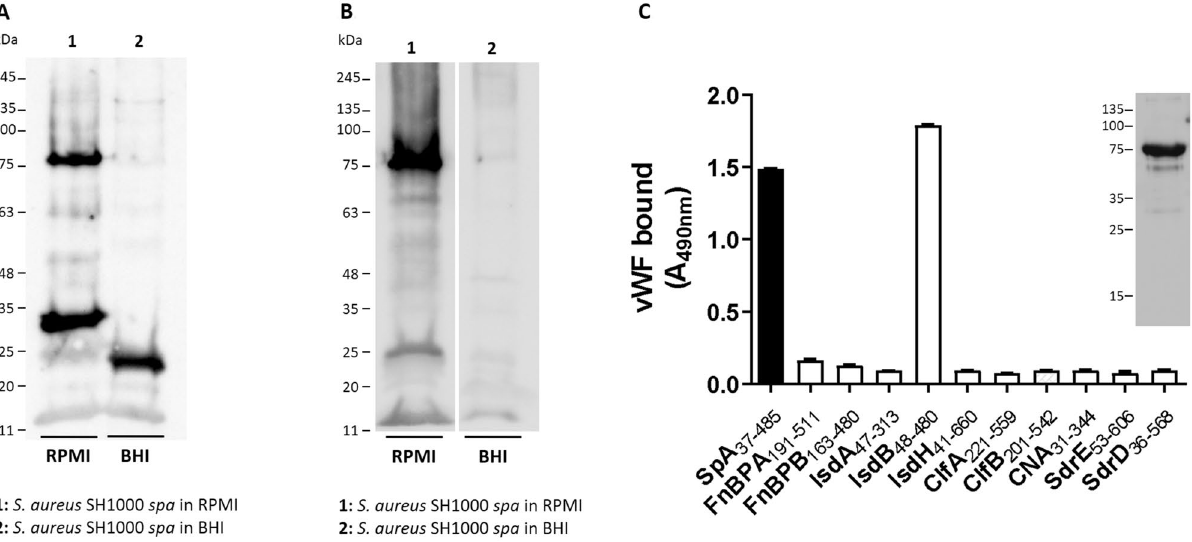
Figure 1. Identification of a vWF receptor in S. aureus SH1000 spa . (A) Lysostaphin-released material from S. aureus SH1000 spa grown in RPMI (lane 1) and BHI (lane 2) was subjected to Far Western Blotting. The nitrocellulose membrane was probed with human vWF followed by polyclonal rabbit vWF antibody and HRP- conjugated goat anti-rabbit IgG. (B) Lysostaphin-released material from S. aureus SH1000 spa grown in RPMI and BHI was subjected to Western Immunoblotting. The nitrocellulose membrane was probed with a rabbit anti-IsdB IgG and HRP-conjugated goat anti-rabbit IgG. Molecular mass standards are indicated on the left of the panels. (C) Binding of vWF to surface proteins from S. aureus . Microtiter wells were coated with purified recombinant A regions of the indicated CWA proteins of S. aureus and incubated with human vWF. Ligand bound to the wells was detected with a polyclonal rabbit vWF antibody followed by HRP-conjugated goat anti- rabbit IgG. The data points are the means ± SD of two independent experiments. In the inset, binding of the vWF to purified recombinant IsdB NEAT1-NEAT2 protein in a Western blotting assay is shown. The full-length blots are presented in Supplementary Fig.